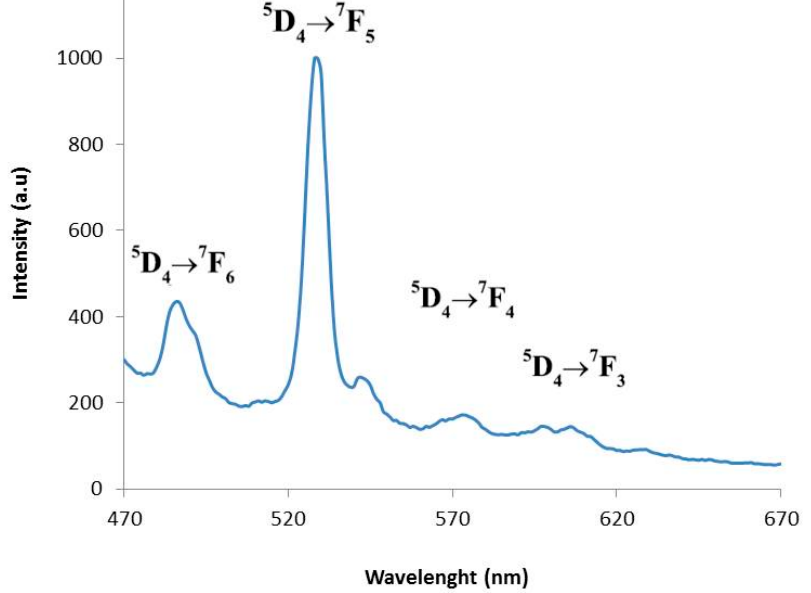
Figure 4. Emission spectrum of terbium MOF.